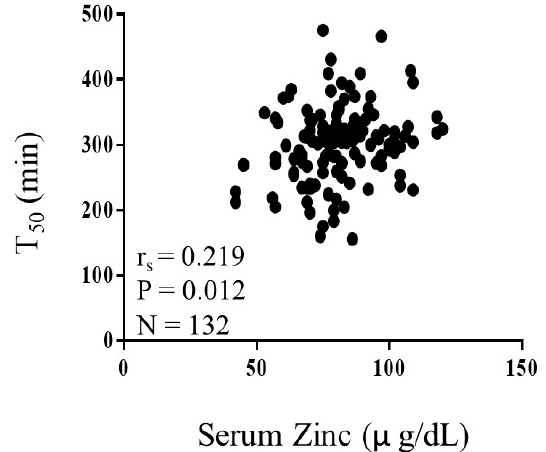
Figure 1. Correlation between serum zinc and serum calcification propensity (T 50 ) in patients with type 2 diabetes mellitus. Serum zinc level showed a weak, but significant correlation with serum T 50 .